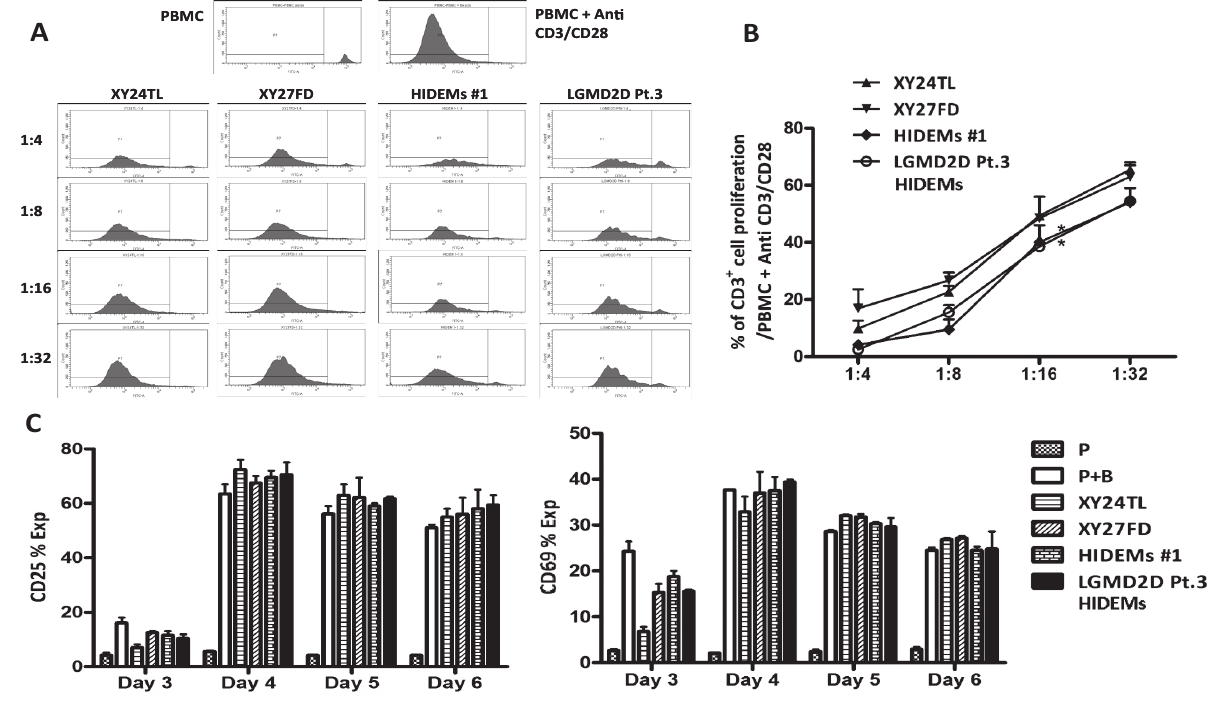
Figure 3. Mesoangioblasts suppress T cell proliferation in a dose-dependent manner without interfering with T cell activation. CFSE- labelled PBMCs (5 × 10 4 /well) were stimulated with anti CD3/CD28 beads (1 × 10 4 /well) (P+B) in the presence or absence of HIDEMs/ mesoangioblasts at decreasing ratios (HIDEM/mesoangioblast:PBMC). On day 6, cells were harvested and stained with anti-CD3 and 7AAD, and analysed by flow cytometry. CFSE dilution was analysed on gated CD3 + 7AAD - cells. Representative histograms showing CD3 + 7AAD - cells with CFSE dilutions after co-culture with HIDEM/mesoangioblast ( A ). The percentage of CD3 + CFSE dividing cells calculated for each group and compared to the positive control (P+B). *p<0.05 ( B ). Cells were harvested on day 3, 4, 5 or 6 and analysed for CFSE dilution and expression of CD25 and CD69. The number of CD3 + 7AAD - cells expressing CD25 or CD69 using counting beads and the % of CD25 + and CD69 + cells were calculated from the data ( C ). Experiments were carried out in duplicates. n=2. Unpaired t tests were used for statistical